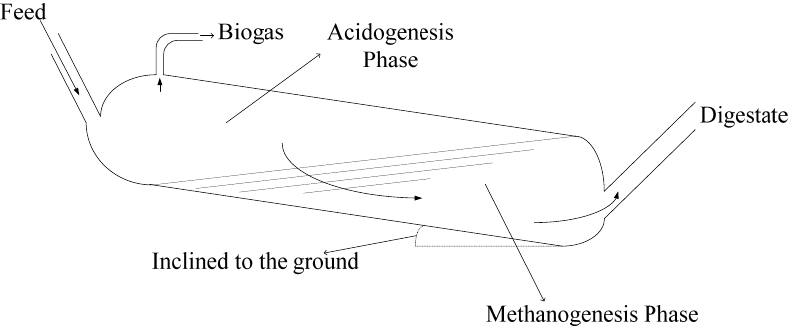
Figure 3. Schematic sketch of a plug flow